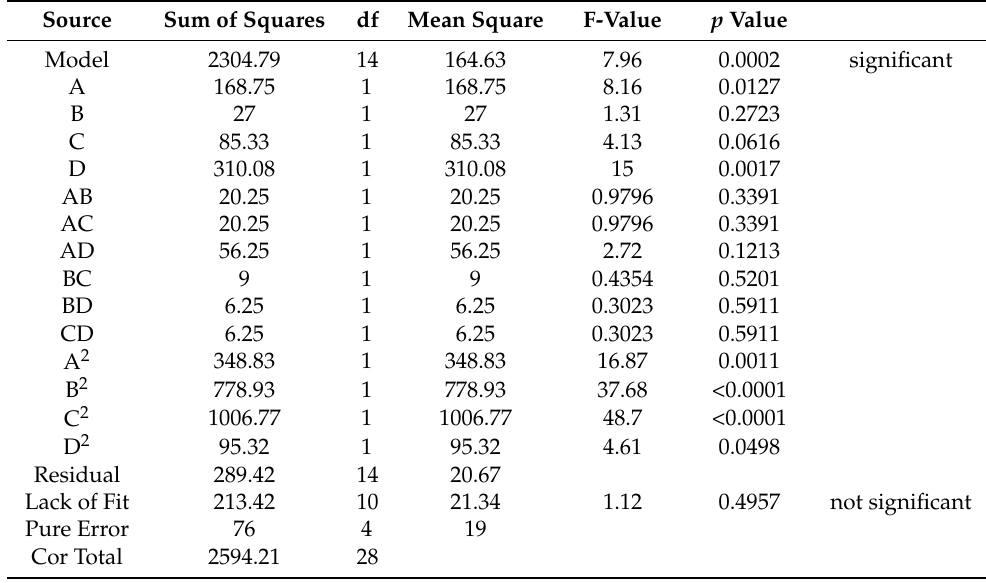
Table 6. Analysis of variance (ANOVA) results for impact resistance.